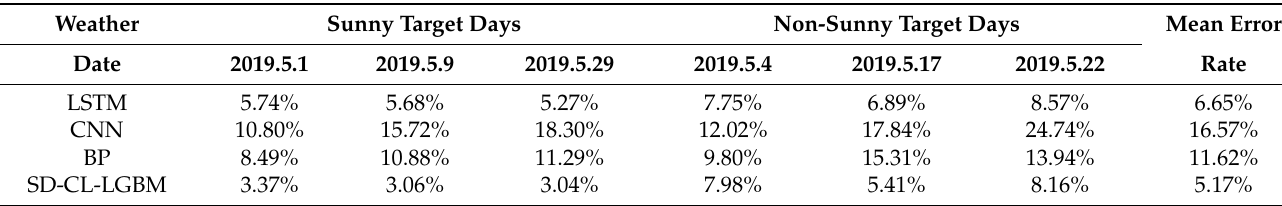
Figure 11. Predicted power and mean error curves for non-sunny target days. Table 5. Comparison of multiple model prediction